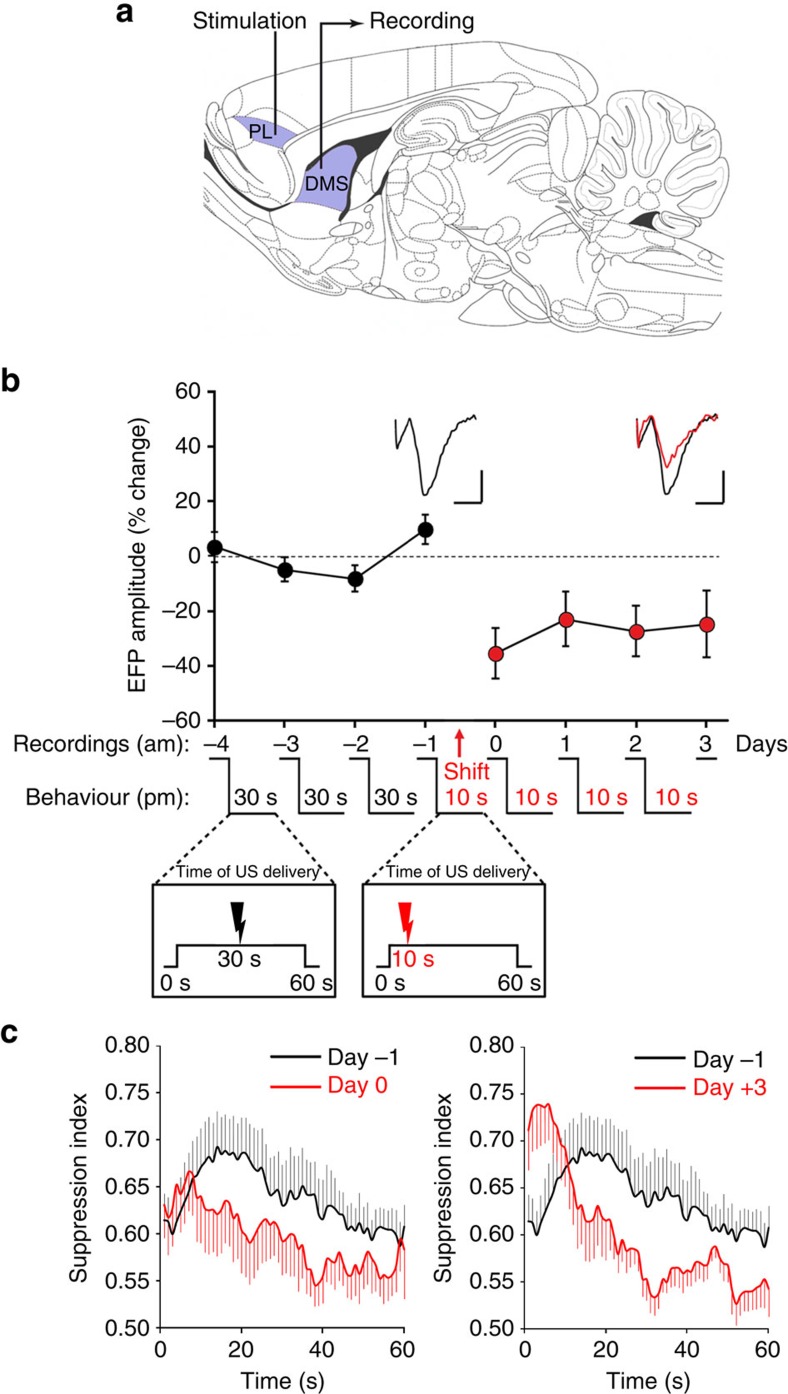
A shift in the CS–US time interval induces LTD-like long-term plasticity at prefronto-striatal synapses.(a) Schematic diagram illustrating placement of the stimulating electrode in the prelimbic cortex (PL) and recording electrodes in the DMS, reproduced in part from ref. 64 with permission. (b) Mean±s.e.m. changes in EFP amplitude for 4 days before (black circles) and 4 days after (red circles) a shift in the CS–US interval (n=11). The experimental design is described on abscissa. EFP recording sessions were performed in the morning (am) and behavioural sessions in the afternoon (pm). Insets: example traces of the EFP before (black) and day +3 after the shift (red). Scale bars, 2 mV, 10 ms. (c) Evolution of the conditioned suppression index (±s.e.m.) during the 60 s tone for the day before the shift (black lines) and the first (left panel) and last (right panel) day after the shift of the CS–US interval (red lines).